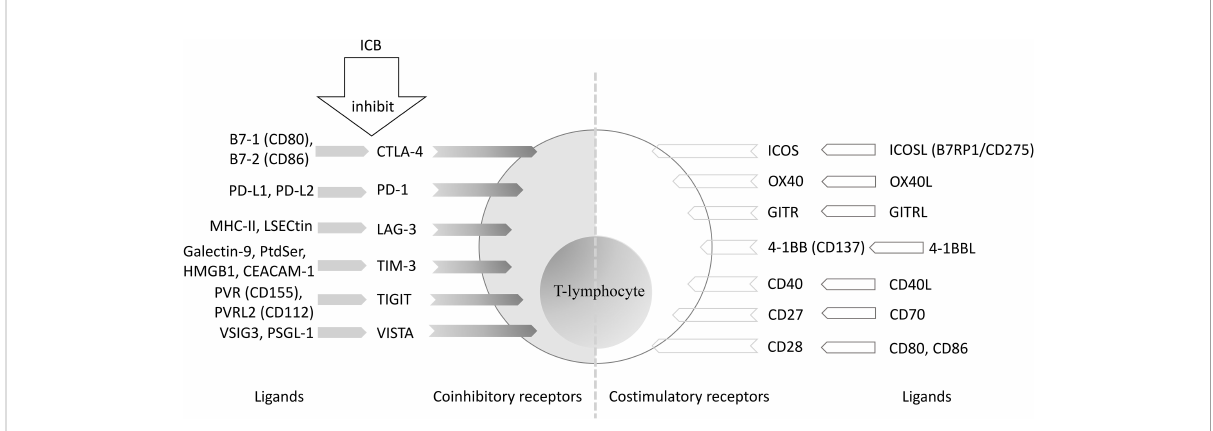
FIGURE 1 T lymphocyte-associated co-stimulatory and co-inhibitory molecules. ICB, immune checkpoint blockade; CTLA-4, cytotoxic T-lymphocyte-associated protein 4; PD-1, programmed cell death protein 1; PD-L1, programmed cell death ligand-1; PD-L2, programmed cell death ligand-2; MHC: major histocompatibility complex; LSECtin, liver and lymph node sinusoidal endothelial cell C-type lectin; LAG-3, Lymphocyte Activation Gene-3; PtdSer, phosphatidylserine; HMGB1, High Mobility Group Protein 1; CEACAM-1, carcinoembryonic antigen-related cell adhesion molecule-1; TIM-3, T cell immunoglobulin and mucin-containing molecule 3; PVR: poliovirus receptor; PVRL2, poliovirus receptor-related protein 2; TIGIT, T cell immunoglobulin and ITIM domains; VISTA, V-domain immunoglobulin suppressor of T cell activation; PSGL-1, P-selectin glycoprotein ligand-1; VSIG3, V-set and immunoglobulin domain-containing 3; ICOS, inducible T-cell co-stimulator; B7RP1, B7-related protein 1; GITR, glucocorticoid-induced tumor necrosis factor receptor; 4-1BB, tumor necrosis factor receptor superfamily member